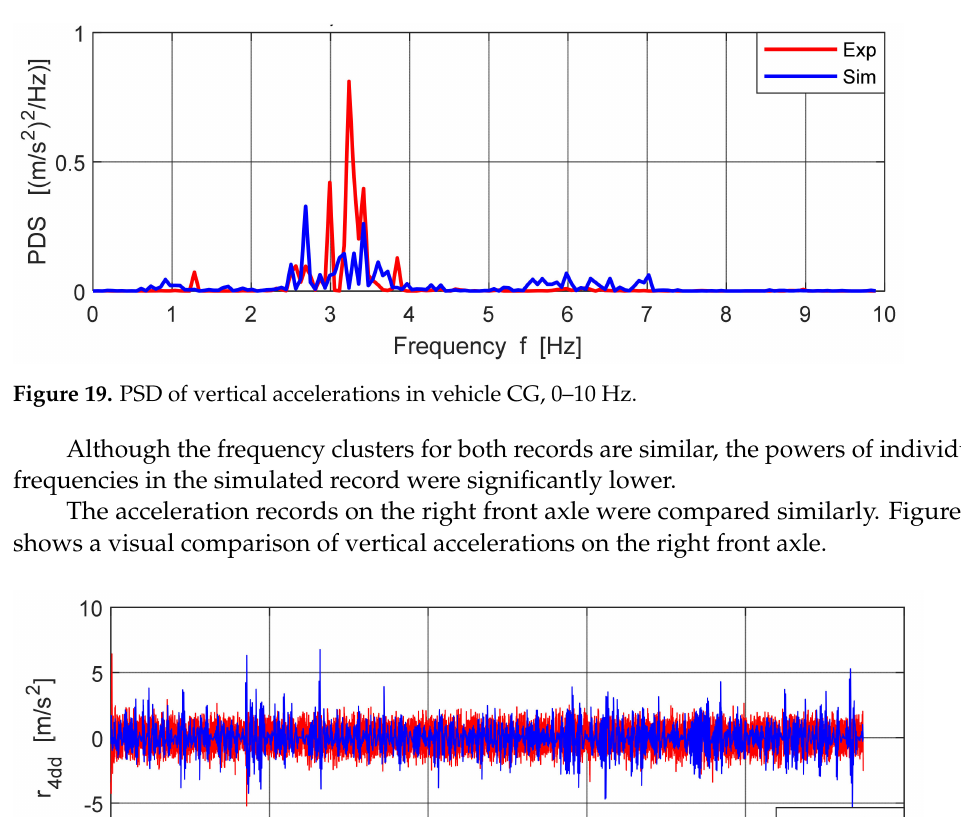
Figure 18. PSD of vertical accelerations in vehicle CG.